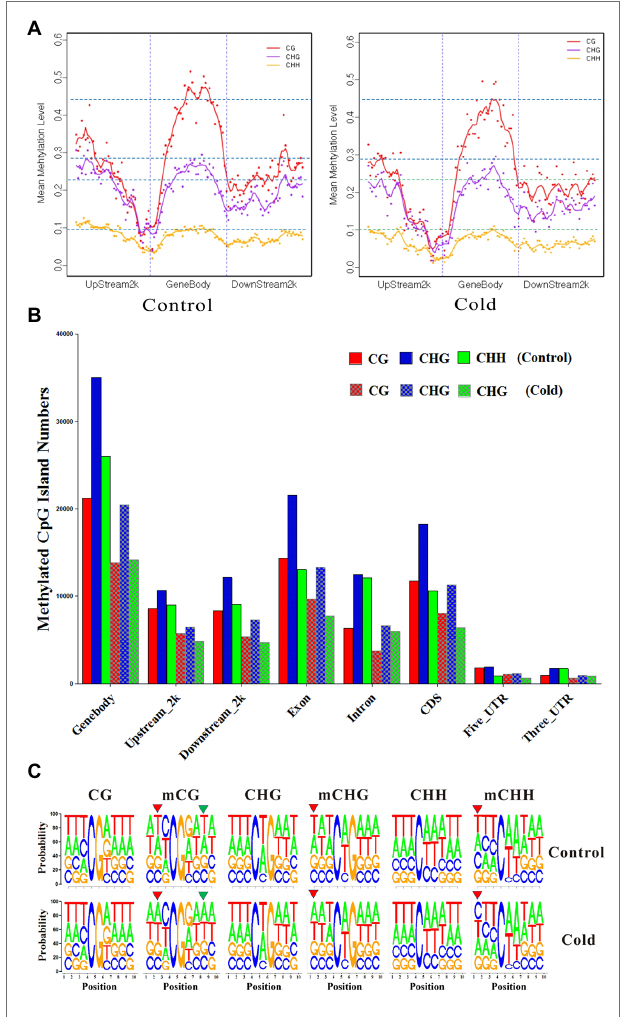
FIGURE 1 | Distribution of methylated cytosines in genic regions and sequence preference after cold treatment. (A) Methylation levels of CG, CHG, and CHH distributed in the gene body, upstream region, and downstream region. Upstream, 2-kb region upstream of the transcription start site; gene body; downstream, the 2-kb region downstream of the transcription termination site. (B) Distribution of mCG, mCHG and mCHH in the gene body, 2-kb upstream region, 2-kb downstream region, exon, intron, CDS, 5-UTR, and 3-UTR. Solid column and squares column histograms represent the control and cold-treated samples, respectively. The data were normalized by the mapping rate and mapping reads. (C) Logos of sequence contexts that are preferentially unmethylated/methylated CG, CHG, and CHH in control and cold-treated samples in which the cytosine is in the fifth position. The logo graphically displays the sequence enrichment at a particular position in the alignment of 10-mers in each